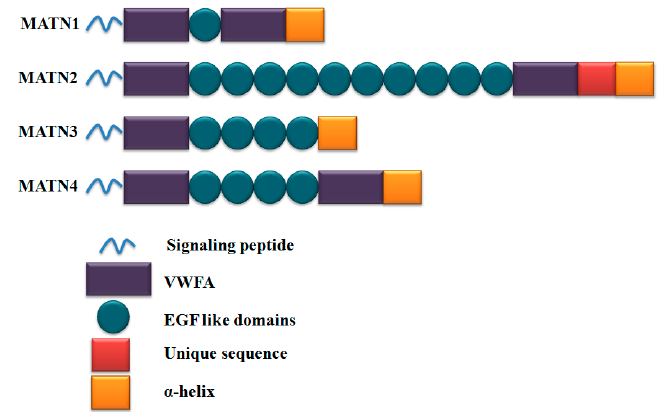
Figure 1. Domain structure of each member of the matrilin family. Each member of the family consists of VWFA, EGF-like domains, and an α -helical oligomerization domain. Abbreviation: MATN, matrilin; VWFA, von Willebrand factor A; EGF, epidermal growth factor.